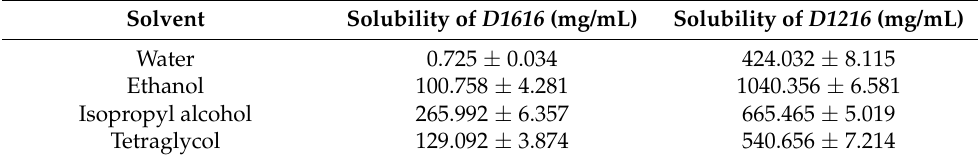
Table 6. Solubility of sucrose palmitate and sucrose laurate in the tested solvents, at 25 ± 2 ◦